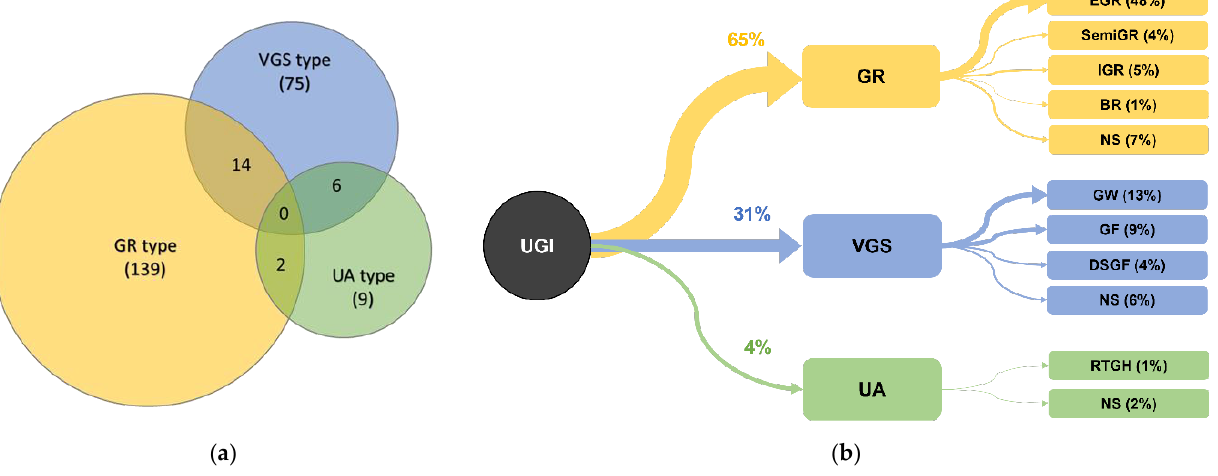
Figure 10. ( a ) Venn diagram of the number of studies, based on the three main UGI categories; ( b ) the distribution of UGI studies according to the categories and subcategories.